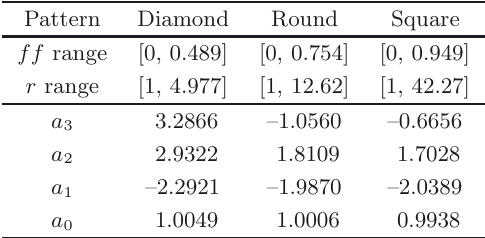
Table A.1. Coefficient to approximate r − 1 ( ff ) with a max- imum relative difference of 5% compared to the